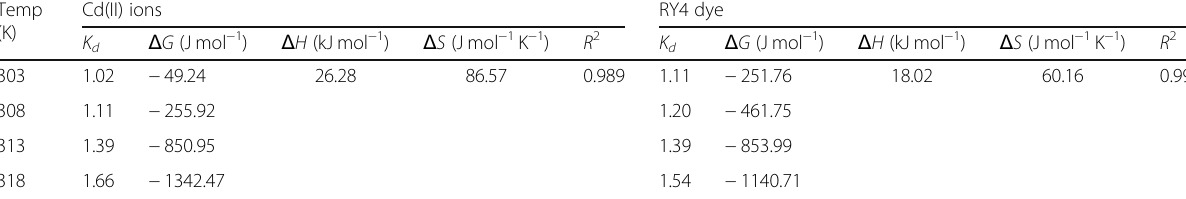
Table 4 Thermodynamic values for uptake of RY4 dye and Cd(II) ion by BMDA Temp